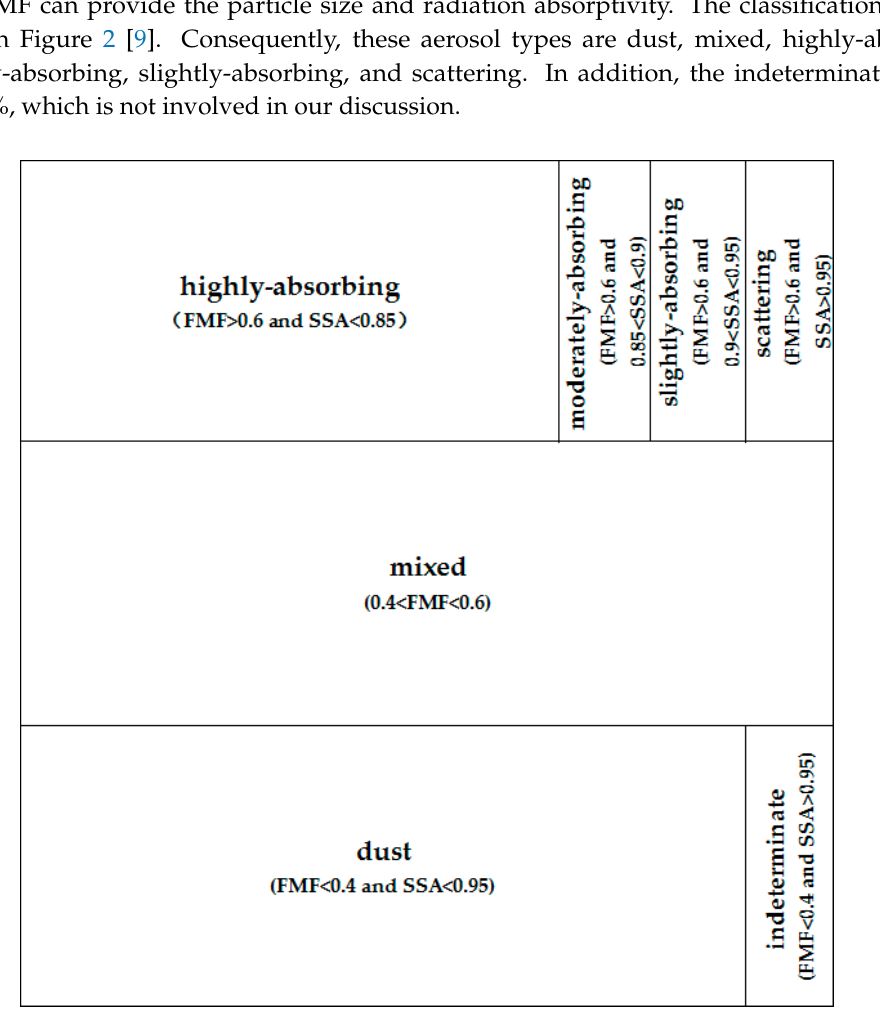
Figure 2. The flowchart of the aerosol classification algorithm created by using FMF and SSA from AERONET: N (Dust) = 382; N (mixed) = 1061; N (highly-absorbing) = 530; N (moderately-absorbing) = 995; N (slightly-absorbing) = 1246; and N (scattering) = 628 (Ns are the totals for both BJ and XH sites).